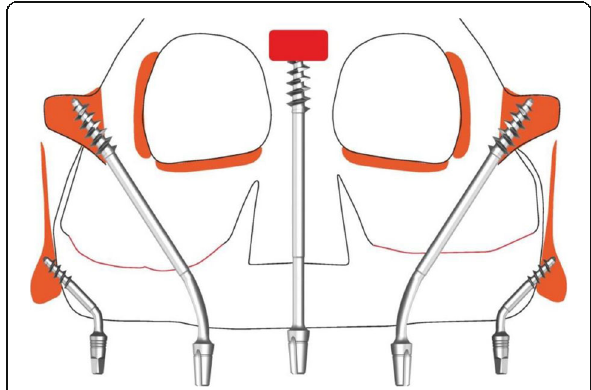
Fig. 4 Schematic planning of the implant placement